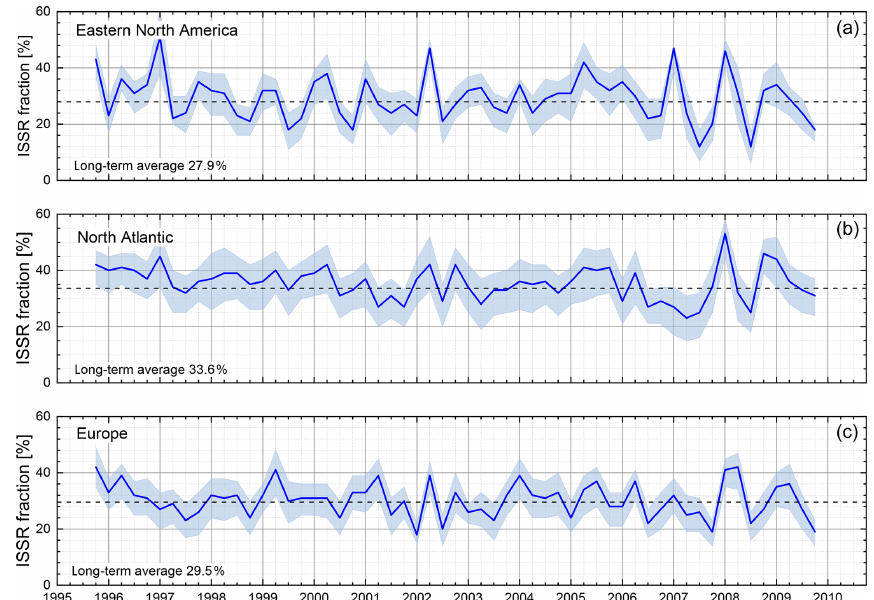
Figure 14. Time series of ISSR fraction (probability of occurrence) for latitudes 40 to 60 ◦ N and for the regions of (from a to c ) eastern North America (105 to 65 ◦ W), the North Atlantic (65 to 5 ◦ W) and Europe (5 ◦ W to 30 ◦ E) for the top UT layer, situated just below the tropopause layer. Solid lines represent probabilities for the average value for RH ice = 100%, the shaded areas represent average fractions for 95% < RH ice < 105% and long-term average values for RH ice = 100% are added in the